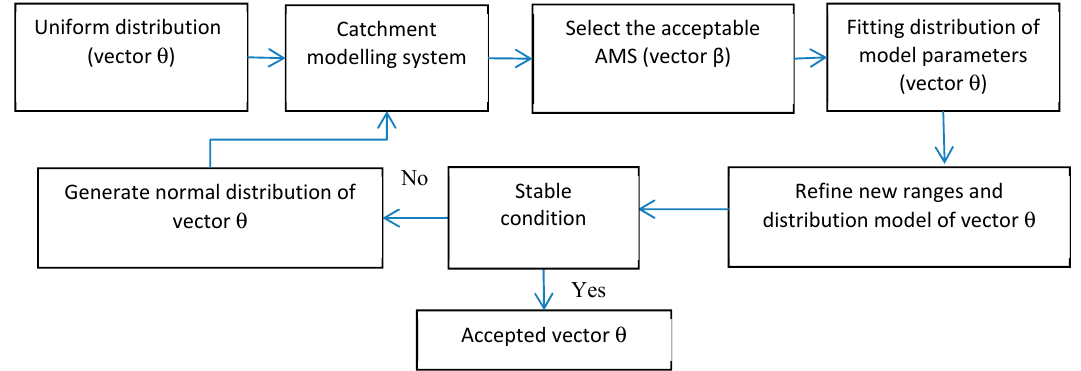
Figure 4. Scheme for the calibration process.